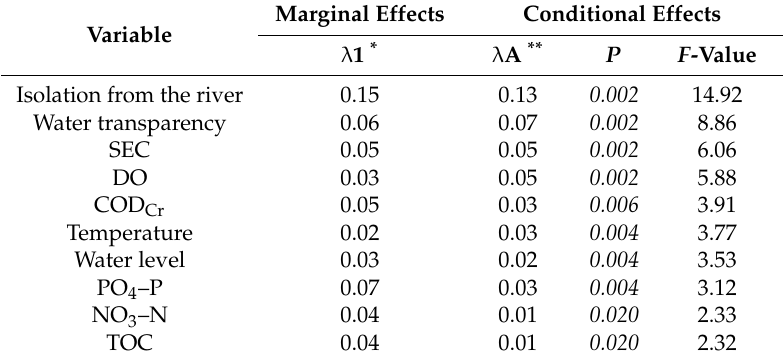
Table 5. Marginal effect (absolute) and conditional effect (additional) explained by each environmental variable in the constrained ordination listed after the automatic forward selection. The P values and F-statistics were obtained by Monte Carlo test (999 permutations).